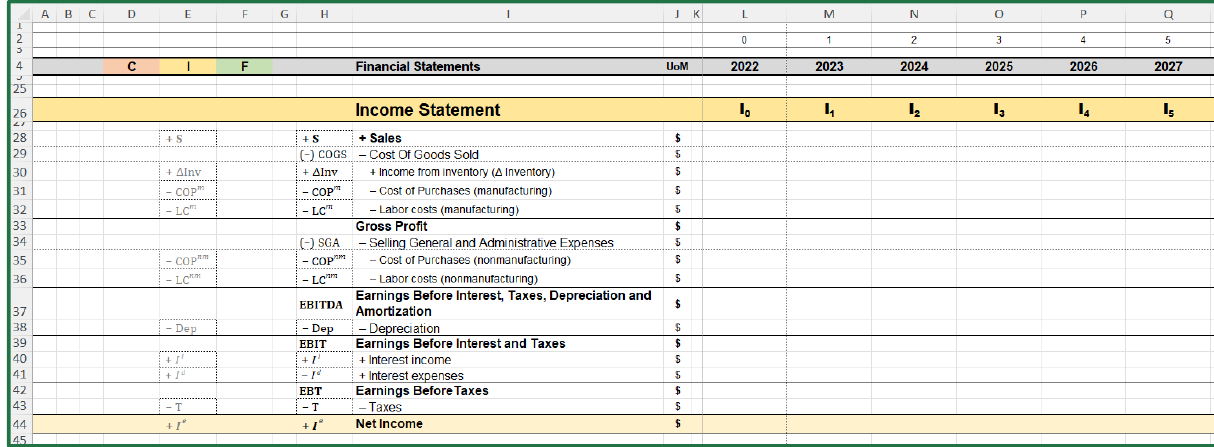
Figure 48. Structure of the balance sheets in the spreadsheet (“ConventionalFinStat” sheet).